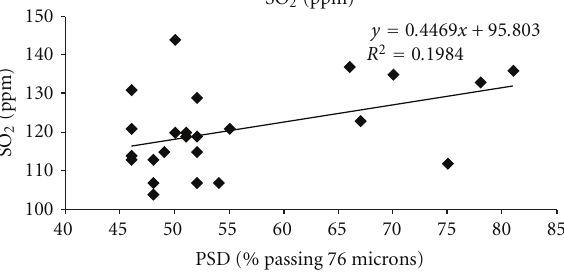
Figure 5: PSD versus SO 2